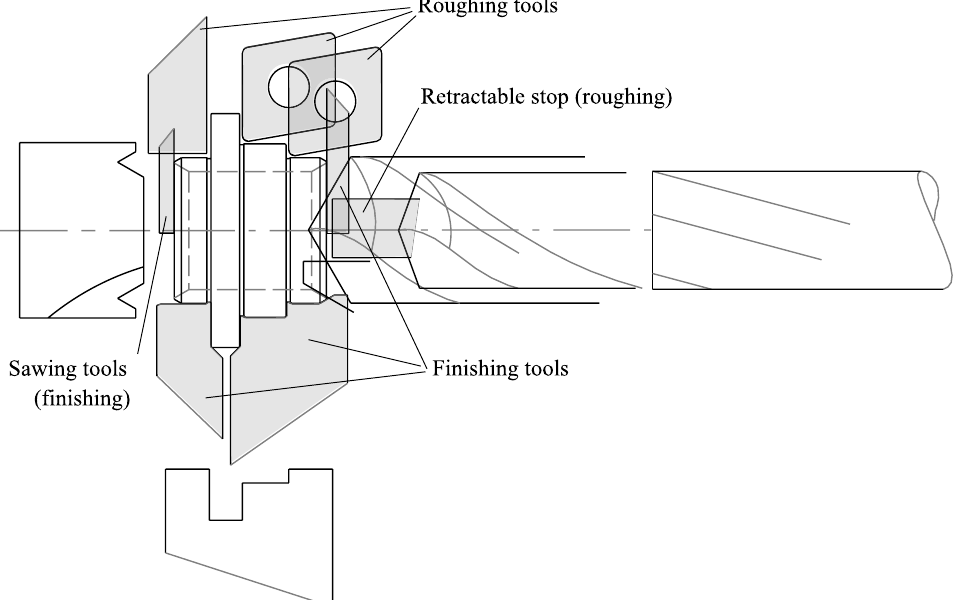
Fig. 2. The thirteen tools used for manufacturing the